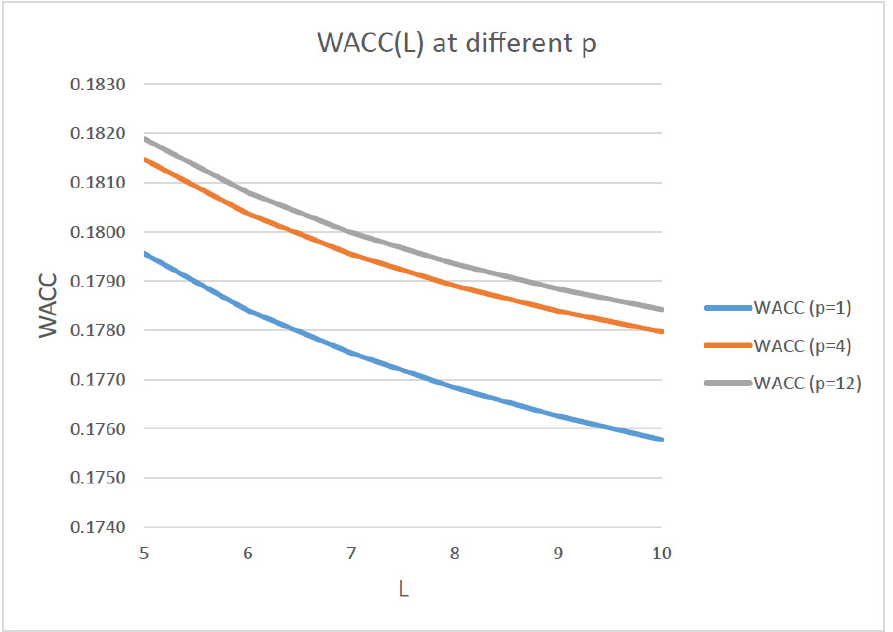
Figure 5. Change of the weighted average cost of capital, WACC, with leverage, L , for k d = 0.14, k 0 = 0.22, p = 1, 4, and 12, and n = 3 (larger scale).